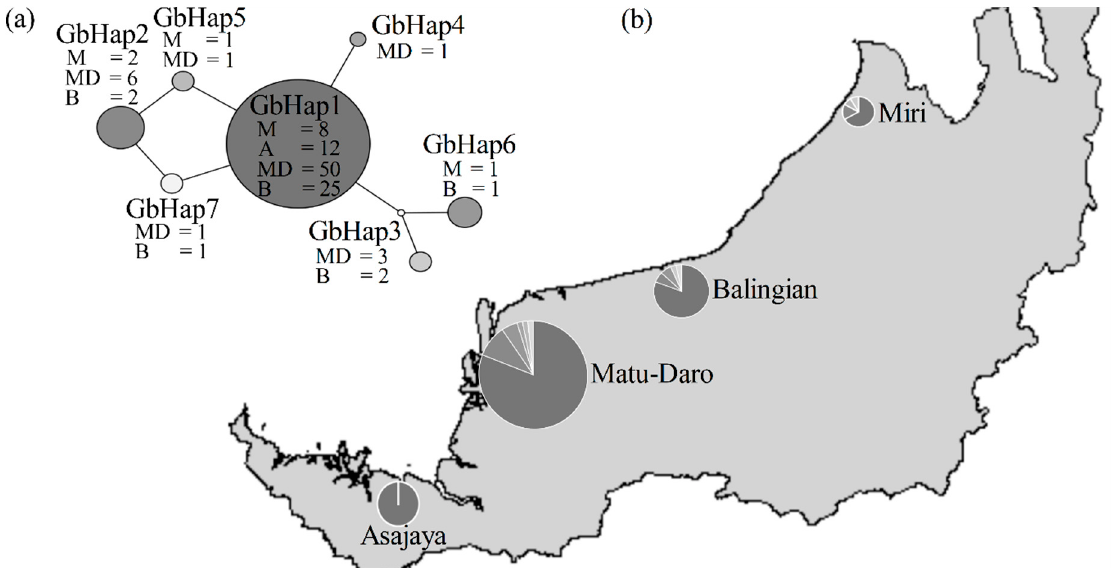
Figure 2. ( a ) Haplotype network of G. boninense based on ITS sequences. Radius of the circle for the haplotype network is proportional to the number of isolates obtained, as shown in the parentheses. The major haplotypes (GbHap1 and GbHap2) are placed in the inner clades. The small circle is a hypothesised missing haplotype. ( b ) Geographical distribution of G. boninense haplotypes according to designated population: Miri (M), Asajaya (A), Matu-Daro (MD) and Balingian (B). The number of specific haplotypes found in a certain location is shown in the haplotype network.